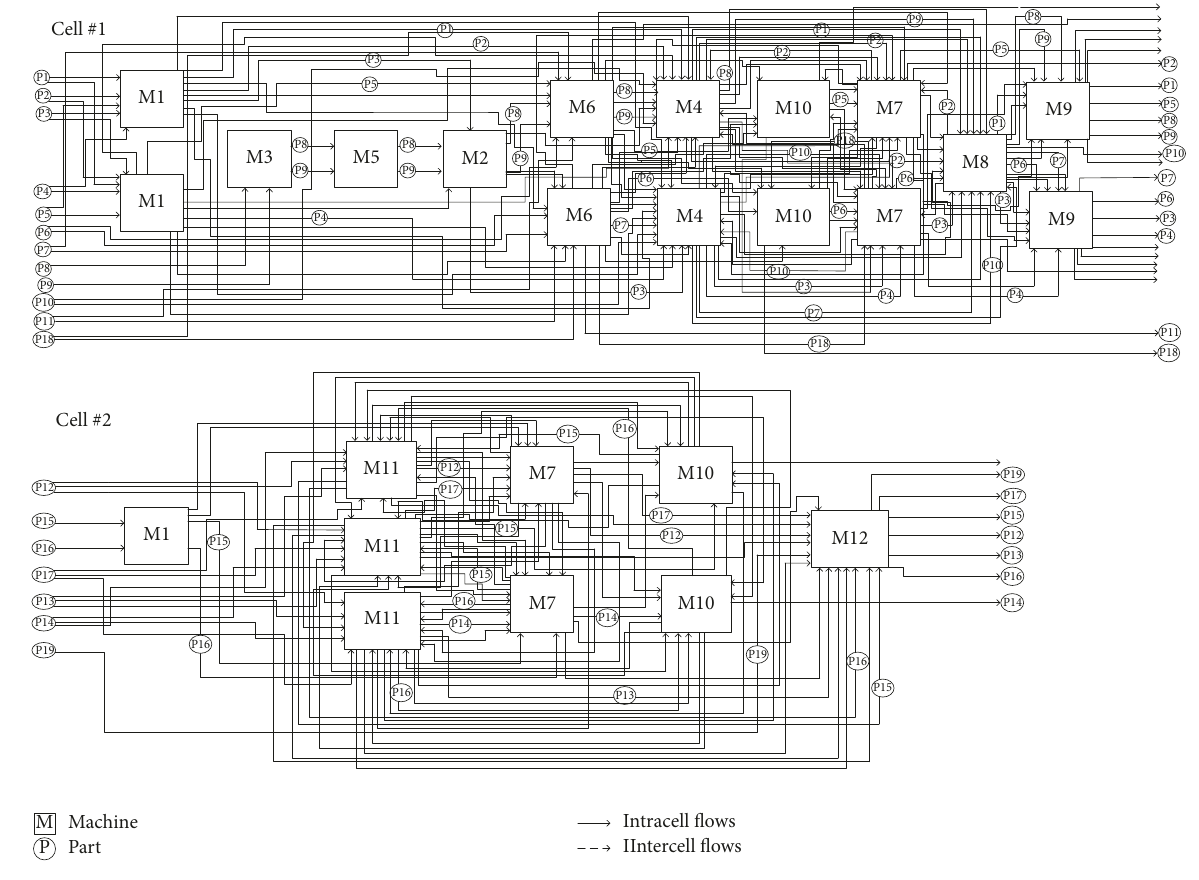
Figure 10: MPC2 and its part flows divided into 2 cells. Table 14: Comparison of static complexity values for Layout #2.